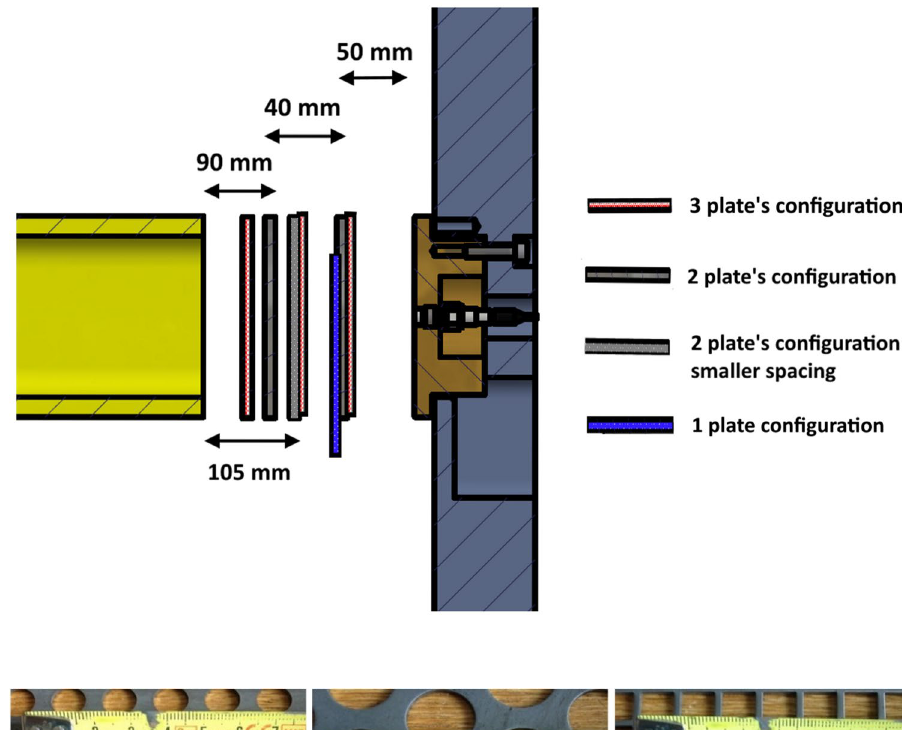
Fig. 2 Position of the plates for each configuration tested